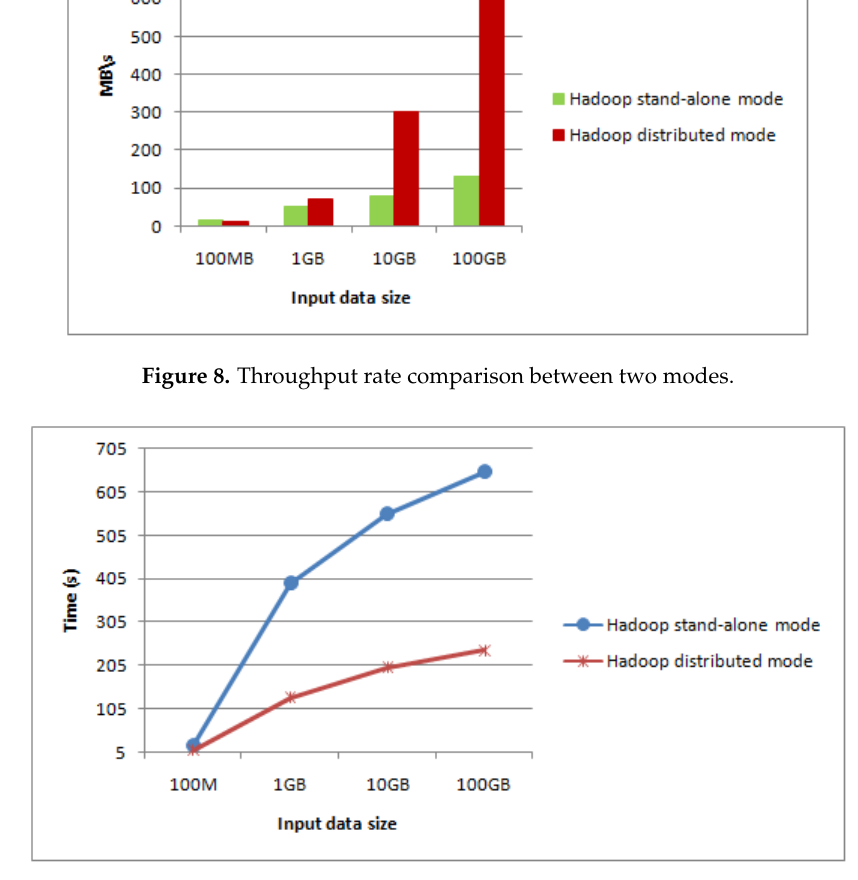
Figure 9. Construction performance comparison between two modes.